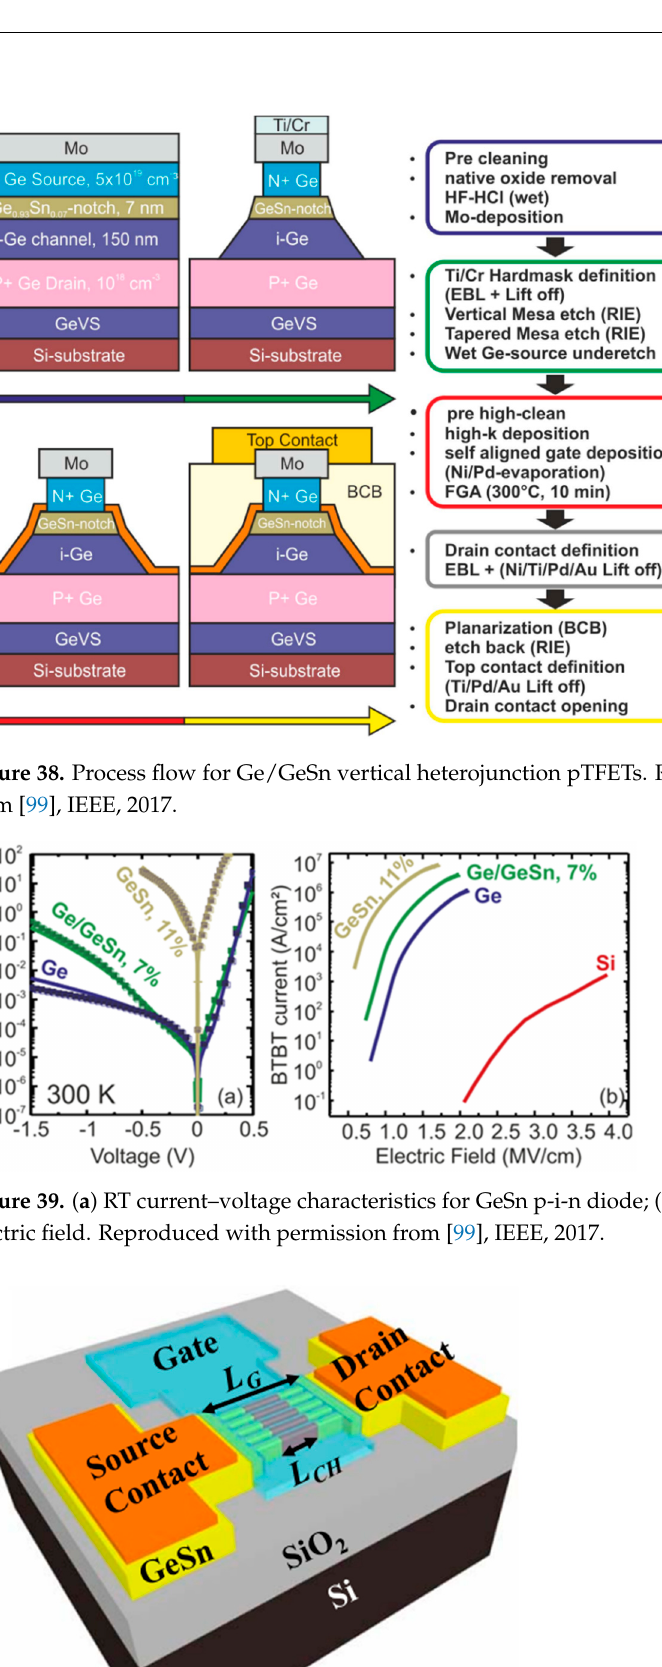
Figure 36. ( a ) Cross-sectional device structure for the first electrically injected FP cavity GeSn/SiGeSn laser; ( b ) calculated band structure and fundamental TE mode profile. Reproduced from [89], OSA Publishing, open access, 2020.